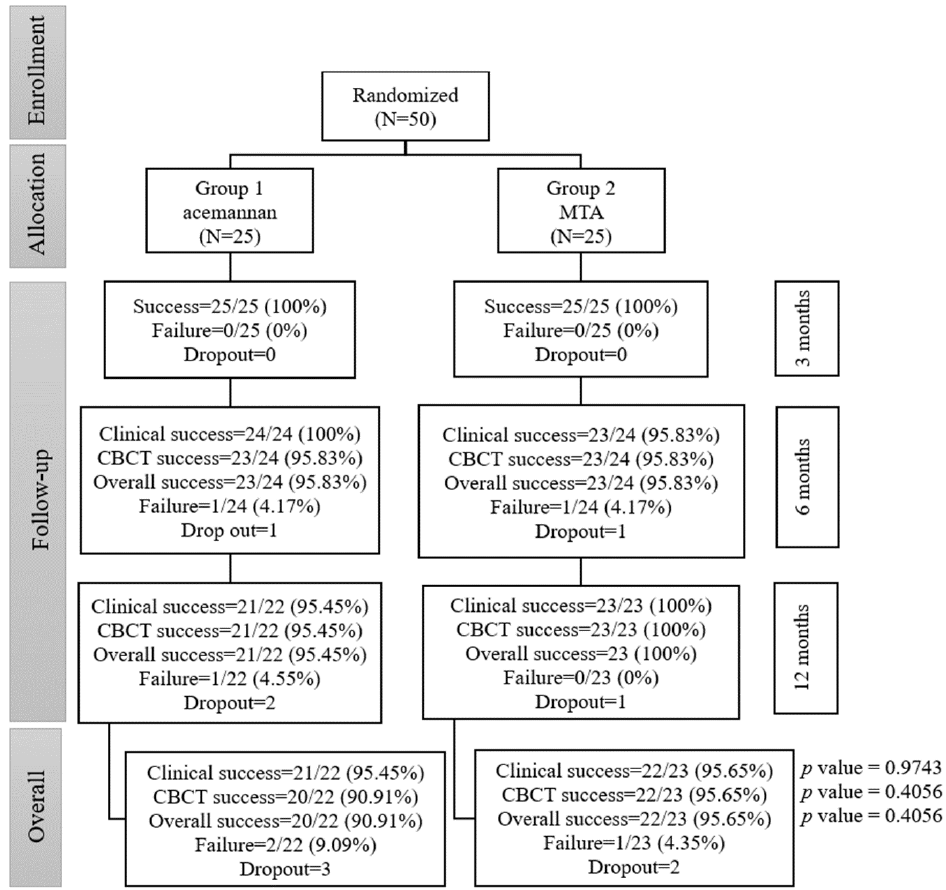
Figure 2. The flow of the participants through each stage of the study. The differences in the overall clinical and radiographic success rates with clinical evaluation and cone beam computed tomography (CBCT) data between the acemannan and mineral trioxide aggregate (MTA) groups were analyzed using the chi-squared test.